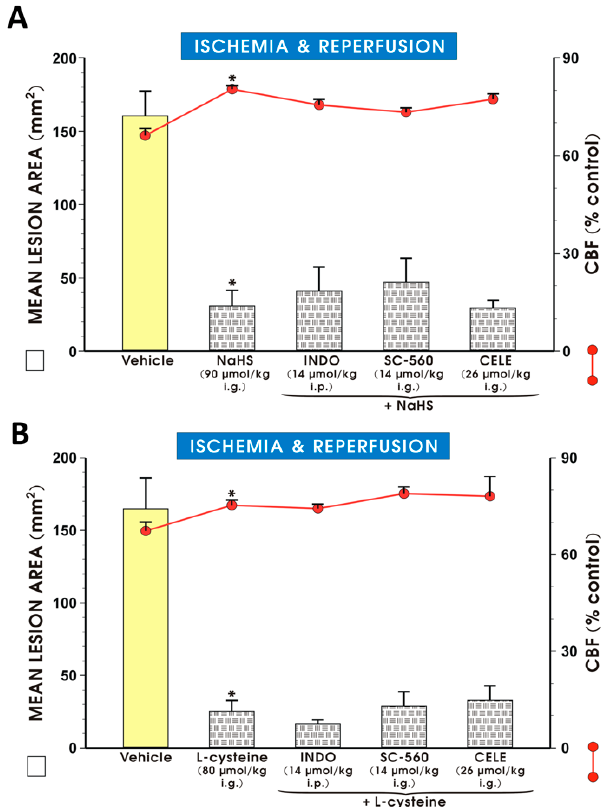
Figure 3. Mean lesion area and GBF in gastric mucosa of rats pretreated with vehicle, NaHS ( A ) or L -cysteine ( B ) alone or in combination with indomethacin (INDO, 14 μ mol/kg i.g.), SC-560 (14 μ mol/kg i.p.) or celecoxib (CELE, 26 μ mol/kg i.g.) and exposed to I followed by 3 h of R. Results are mean ± S.E.M of 4-5 rats per each experimental group. A significant change as compared with the respective values in the vehicle-control is indicated by asterisks ( p < 0.05).